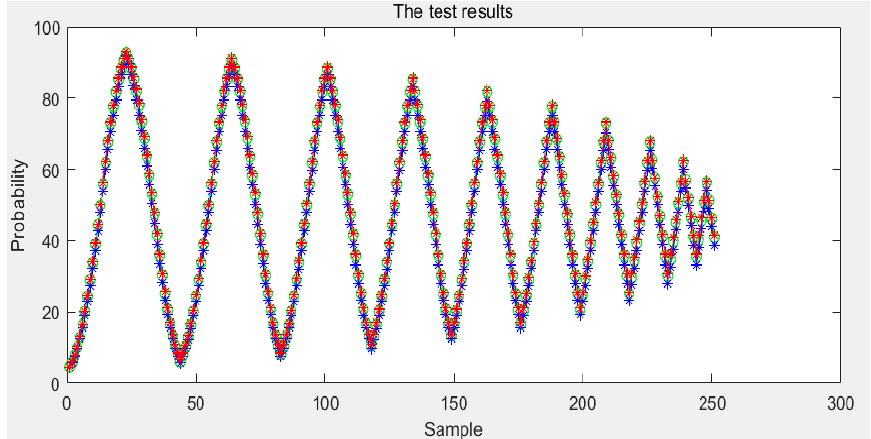
Figure 12. Test results of the first kind sensor.